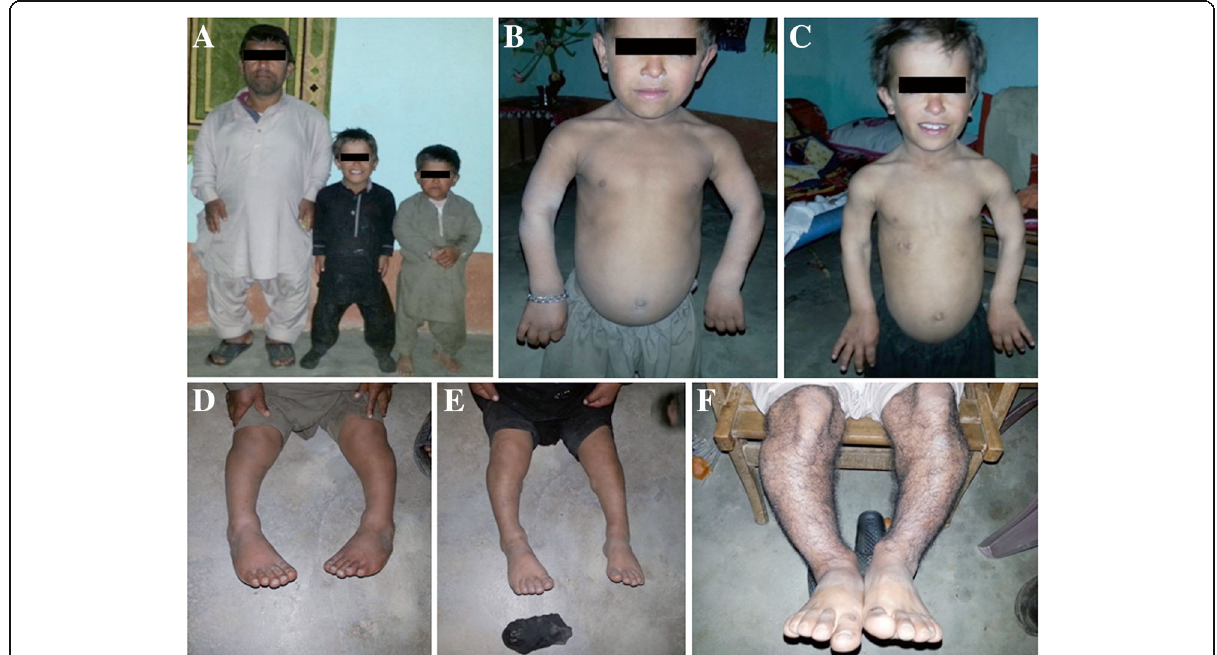
Fig. 1 Clinical presentation of a Pakistani family with autosomal dominant achondroplasia: ( a ) Affected individuals showing short stature with near to normal head growth. Shortened hands of father (II-3) are prominent but not evident in children due to their younger ages. b , c Represent affected individuals III-1 and III-2 in the pedigree respectively; facial and skull growth pattern is near to normal with mild flat nasal bridge. Axial skeleton is less affected, whereas shortened humerus is prominent. d , e Affected individuals III-1 and III-2 in the pedigree respectively; both children are displaying bilateral bowing of legs and little feet intoeing. f Affected individual II-3 in the pedigree; an adult presenting characteristic bilateral bowing of